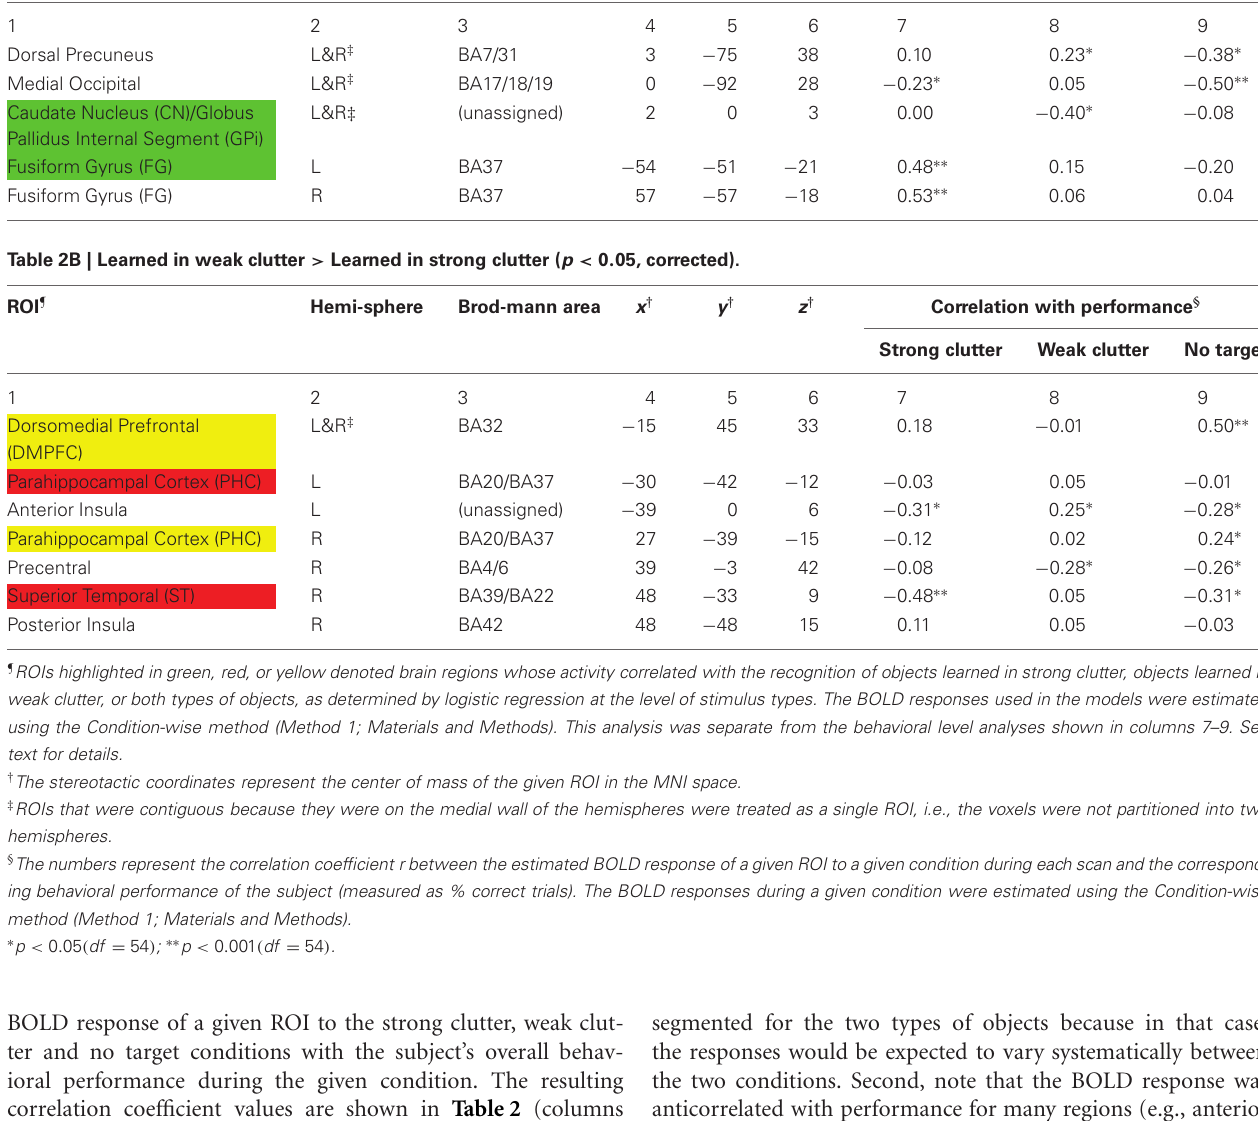
Table 2 | Brain regions involved in object recognition in clutter. Table 2A | Learned in strong clutter > Learned in weak clutter ( p < 0 . 05, corrected).